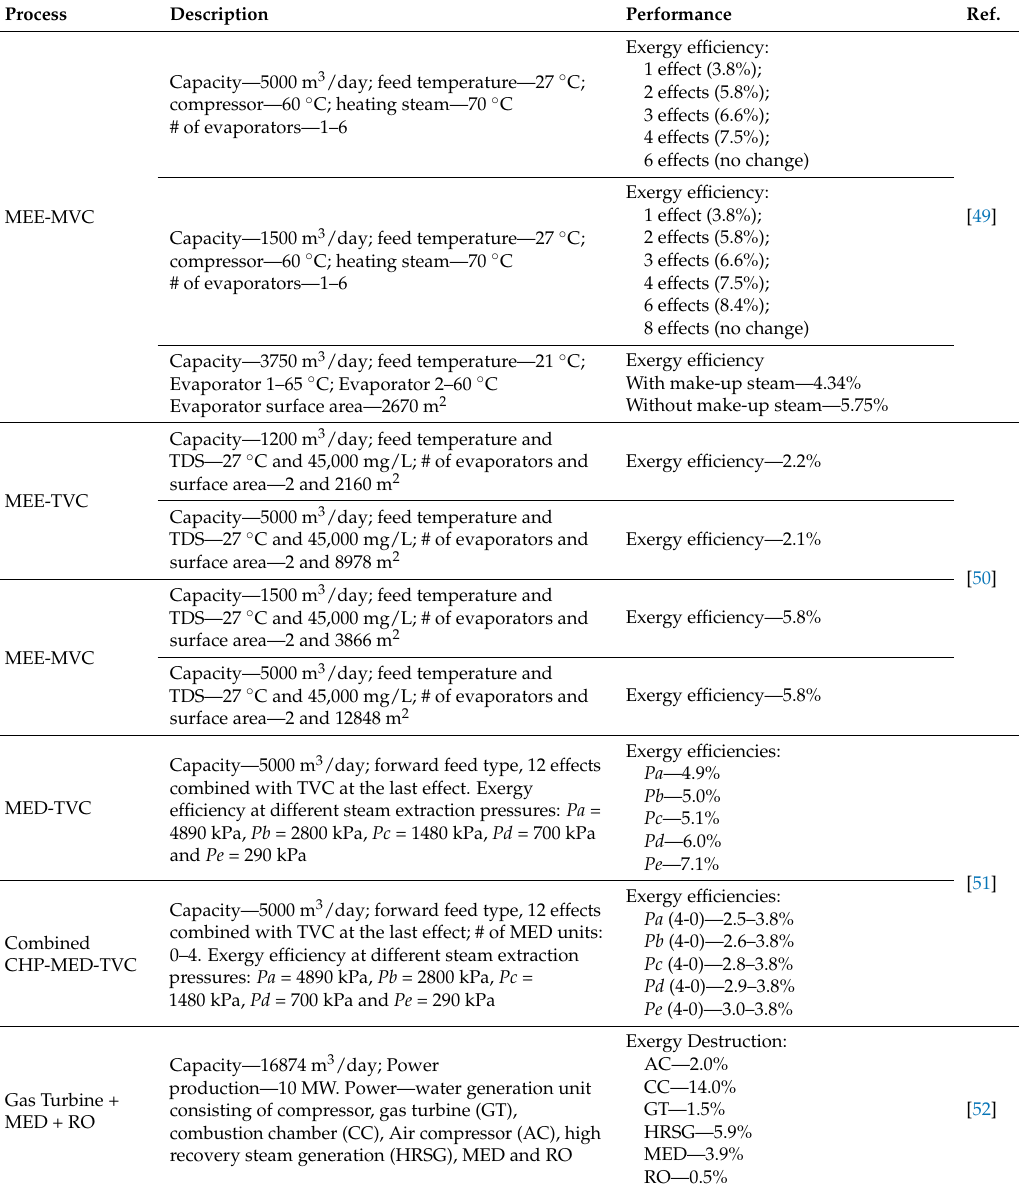
Table 4. Exergy performance in MED and Hybrid